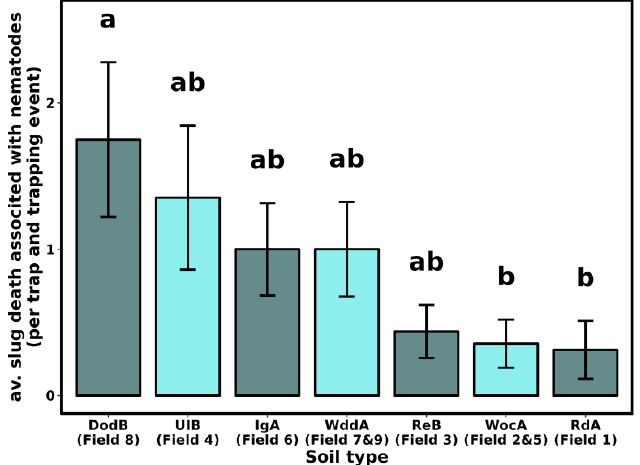
Figure 4. Average number of slugs death associated with the presence of nematodes per trap (4 traps of 1 m 2 ) and per trapping event (4) by soil types. Soil types were identified on Web Soil Survey [43] , based on field location, as Downer sandy loam (DodB), Ingleside sandy loam (IgA), Reybold-Queponco complex (RdA), Reybold silt loam (ReB), Unicorn loam (UIB), Woodstown sandy loam (WddA), Woodbridge loam (WocA). Short descriptions of the soil types are provided in Table 1. Bars indicate SEM. Letters indicate statistical differences between soil types.